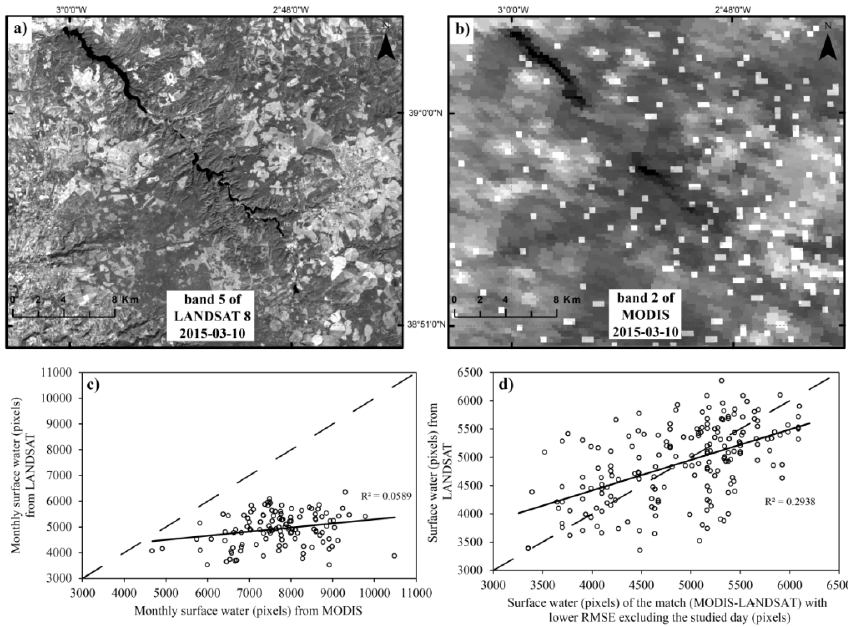
Figure 8. Surface reflectance map for the day 2015-03-10: ( a ) from LANDSAT; ( b ) from MODIS. Monthly surface water identified by LANDSAT vs. MODIS: ( c ) using them independently; ( d ) using matches of images.